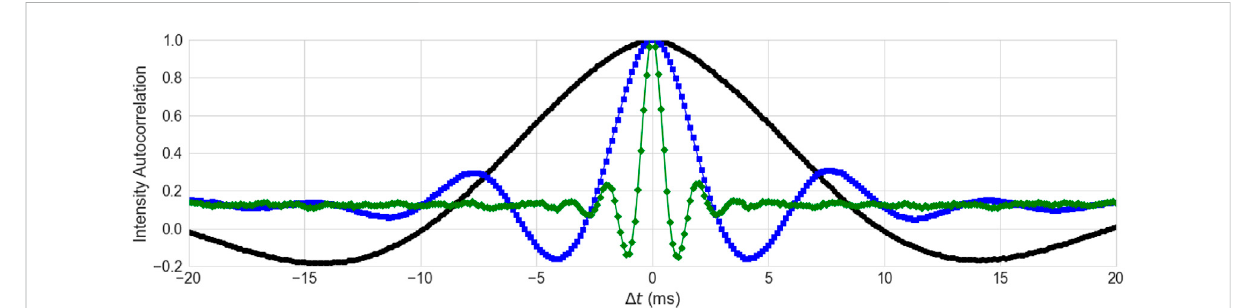
FIGURE 13 Normalizedintensity autocorrelation function g ( Δ t ) as de fi ned inMethods for thethree kymographs shown inFigure 2, _ γ (cid:1) 10 s − 1 , z = 3 μ m ( ○ ), _ γ (cid:1) 20 s − 1 , z =6 μ m ( ■ ),and _ γ (cid:1) 30 s − 1 , z =20 μ m ( A ).Thewidthofthecentralpeakandthepositionofthe fi rstminimumareproportionaltothe fl ow speed, for fi xed positional con fi gurations, but both measures are have a some sensitivity to the presence of positional